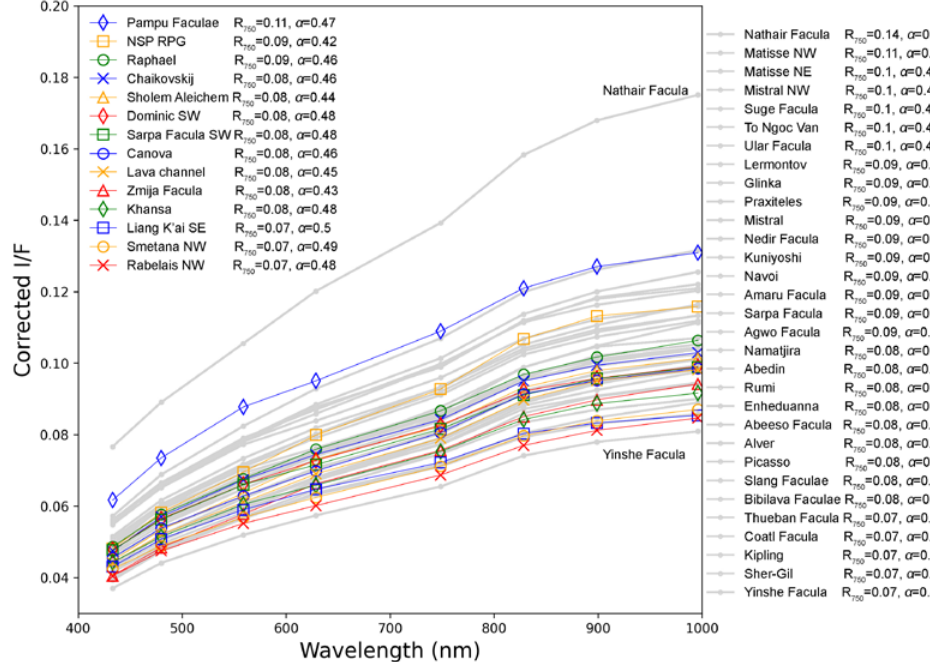
Figure 4. Comparison of reflectance spectra of pyroclastic deposits formed by pitted-ground terrains and the other typical explosive volcanoes on Mercury. The spectral data are acquired from the eight-band global color mosaic [31]. Spectral anomalies developed around typical explosive volcanoes marked by grey lines, and those developed around pitted-ground terrains are marked in other colors (see legend). R750 is the reflectance of 750 nm and α is the spectral slope at visible to near-infrared wavelengths as represented by R430/R1000 [38]. The spectra of the other typical pyroclastic deposits on Mercury are sorted up to down by values of R750. The spectral sampling locations are shown in the Figures S1–S7 of Supplementary Materials.